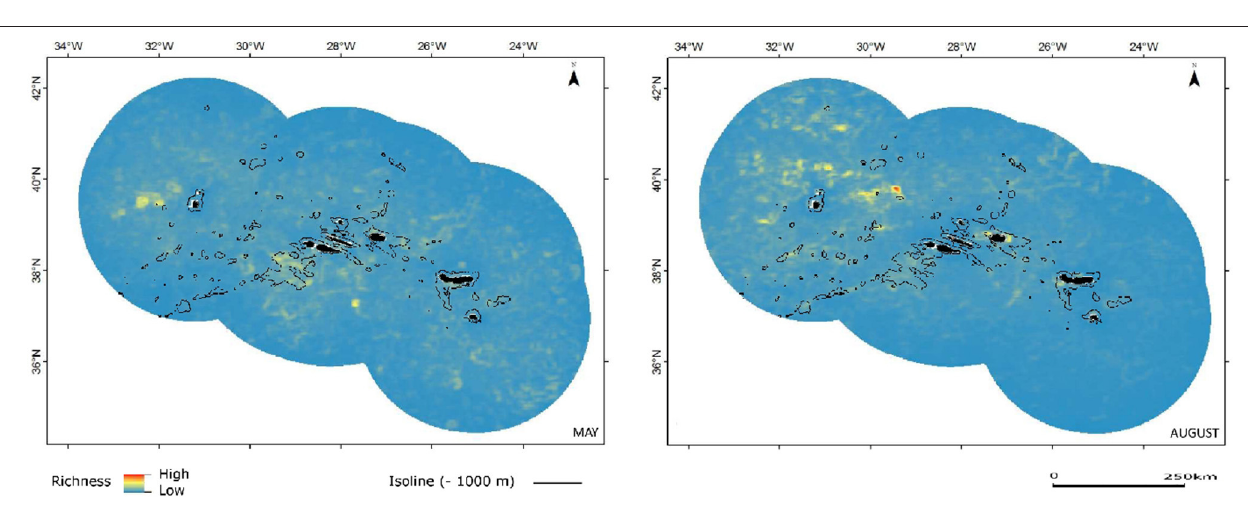
FIGURE 5 | Combined predicted richness of small dolphins in spring (May) and summer (August). Color scheme as in Figure 3